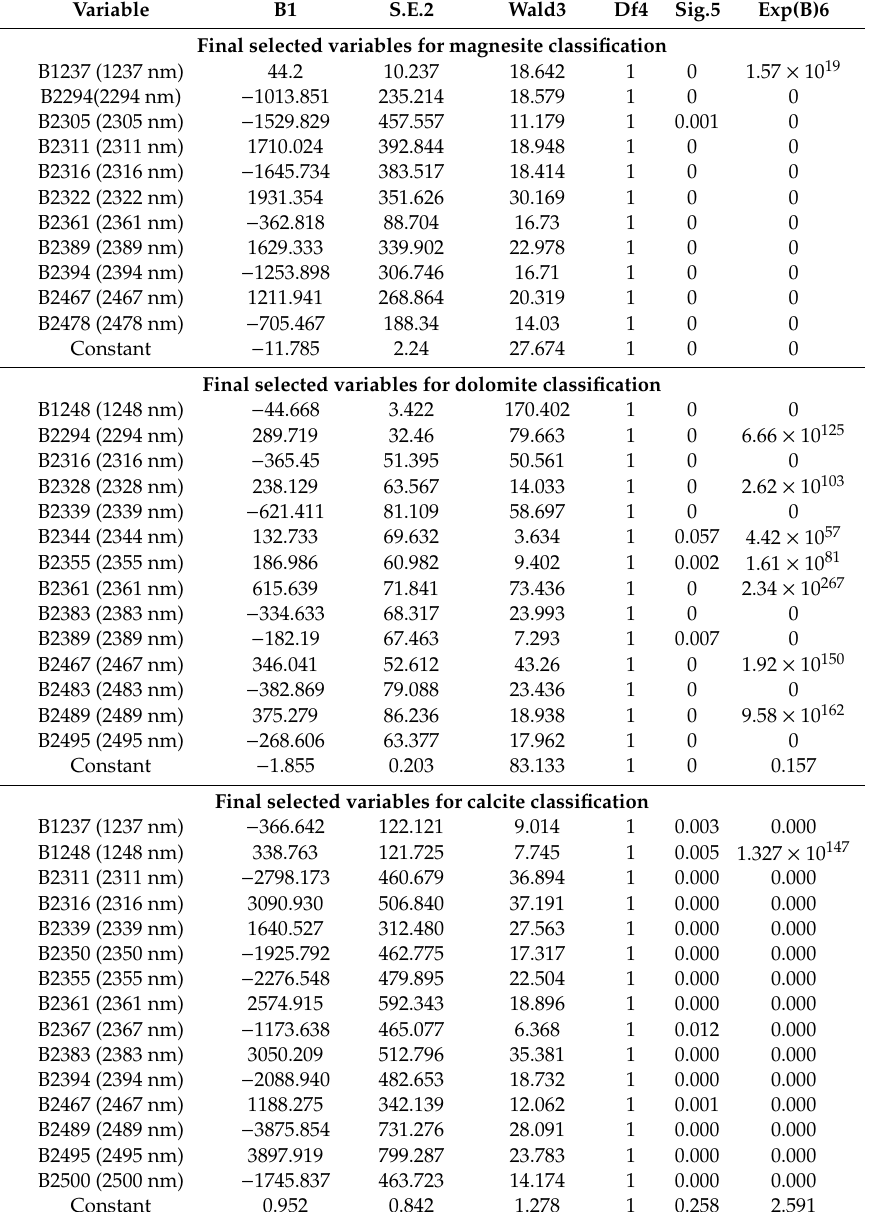
The final selected variables in the equation and Wald test results from the logistic regression